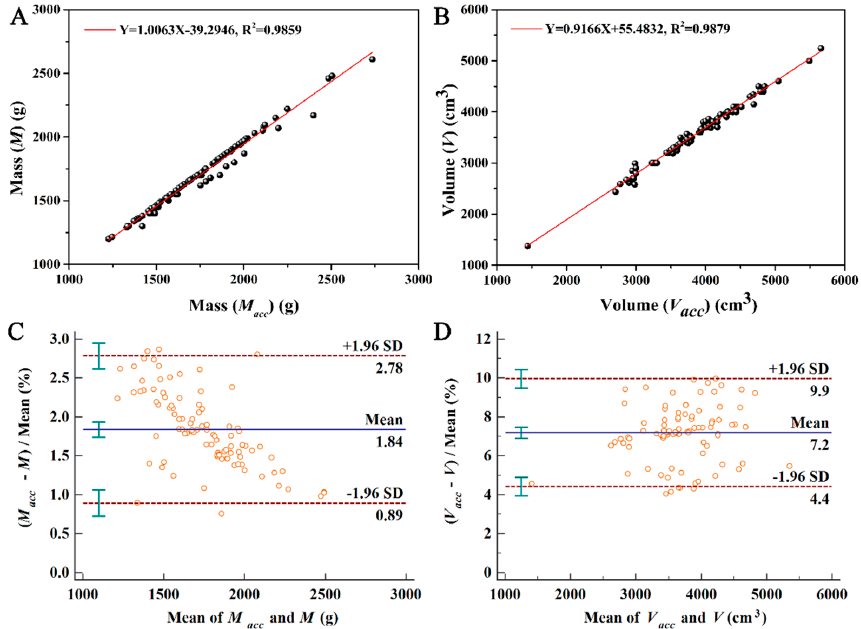
Figure 9. ( A ), ( B ) Linear fitting analysis of mass ( M and M acc ) and volume ( V and V acc ), respectively; ( C ), ( D ) Bland–Altman plot of mass ( M and M acc ) and volume ( V and V acc ), respectively.